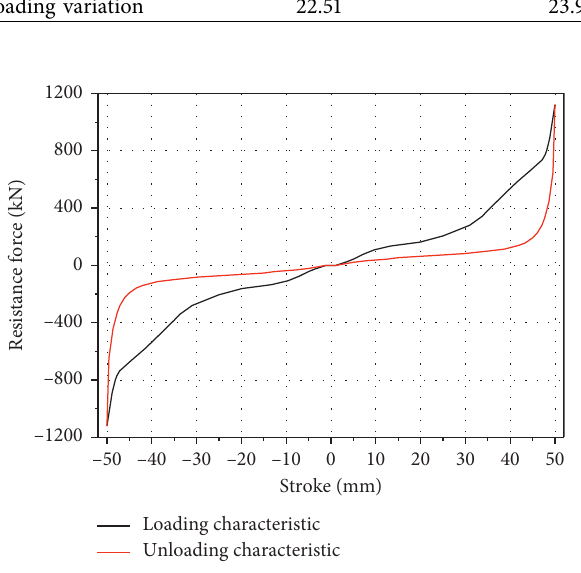
Figure 13: Optimized characteristics of draft